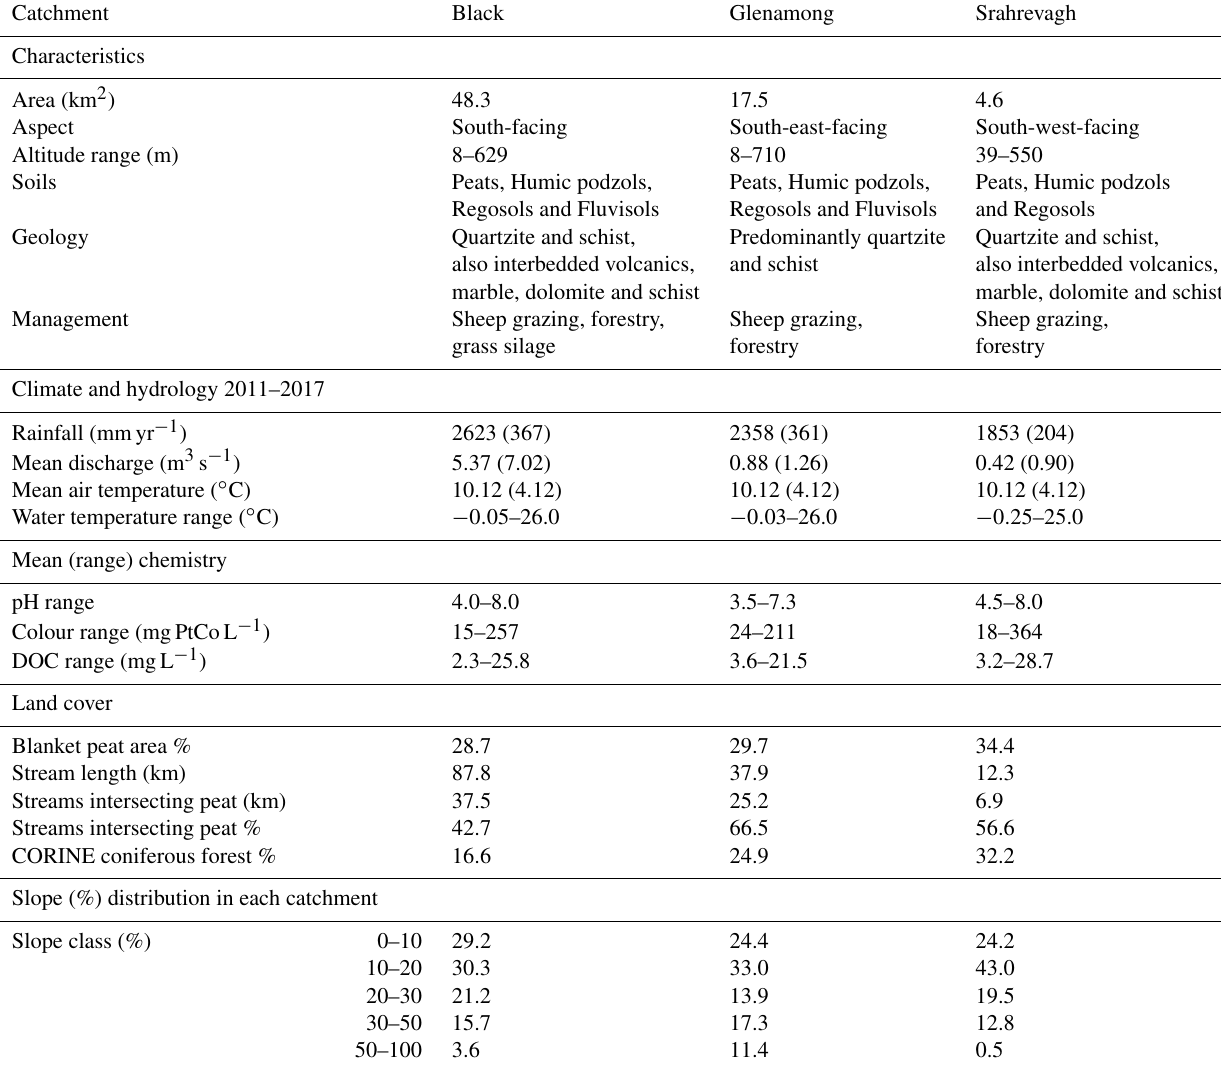
Table 1. Sub-catchment characteristics, climate (recorded at Newport climate station) and hydrology and stream water chemistry data for the Black, Glenamong and Srahrevagh